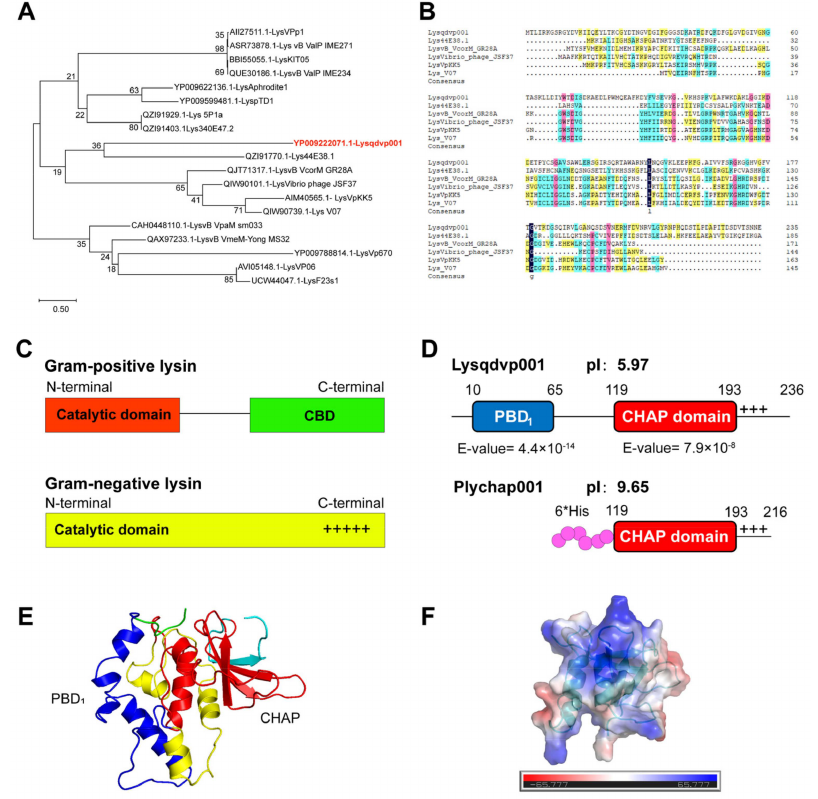
Figure 1. Bioinformatic analysis of Lysqdvp001. ( A ) Phylogenetic tree showing the evolutionary relationship of Lysqdvp001 and related V. parahaemolyticus lysins. Amino acid sequences were aligned using Clustal W and the phylogenetic relationships were calculated by the neighbor-joining